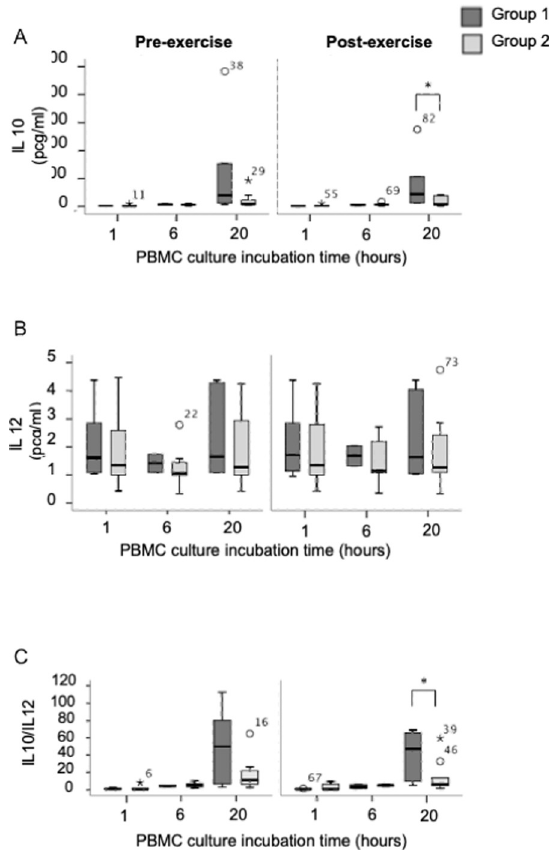
Fig 4. A) IL-10 (pcg/ ml), � p = 0.045 B) IL-12 (pcg/ ml), C) IL-10/IL-12 ratio from cell medium supernatant of PBMC cultured from patients with (Group 1) and without (Group 2) rise in urinary NAG/Creatinine ratio following